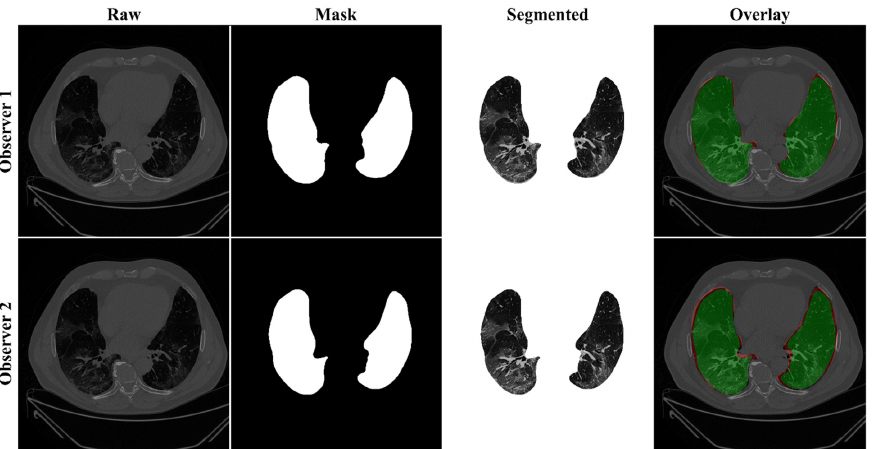
Figure 7. Results from PSP Net while using Observers 1 and 2. Columns are the raw, binary mask output, segmented lung region, and overlay of the estimated lung region vs. ground truth region.